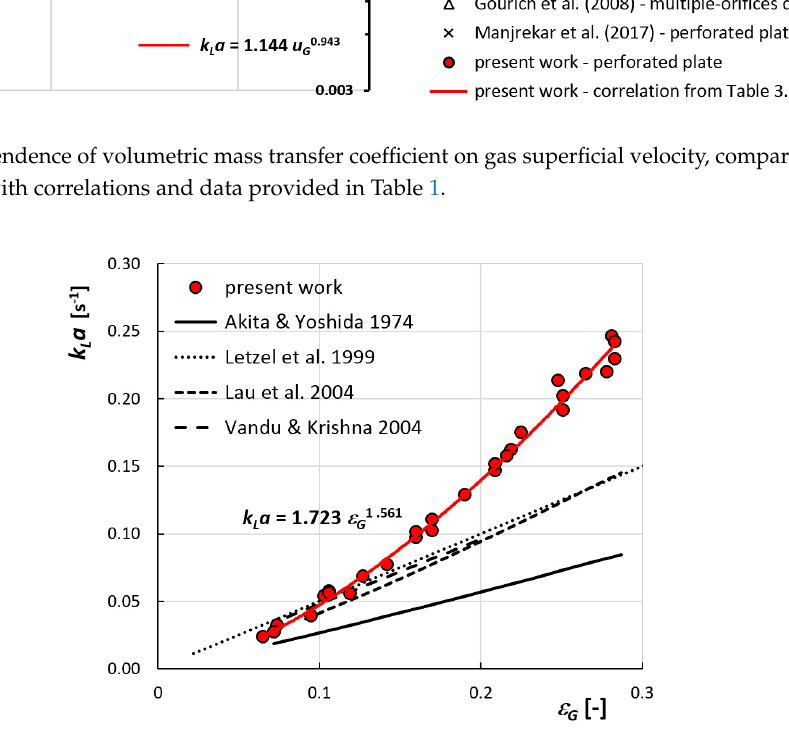
Figure 8. Dependence of volumetric mass transfer coefficient on corresponding gas holdup, comparison of present data with available correlations provided in Table 1.